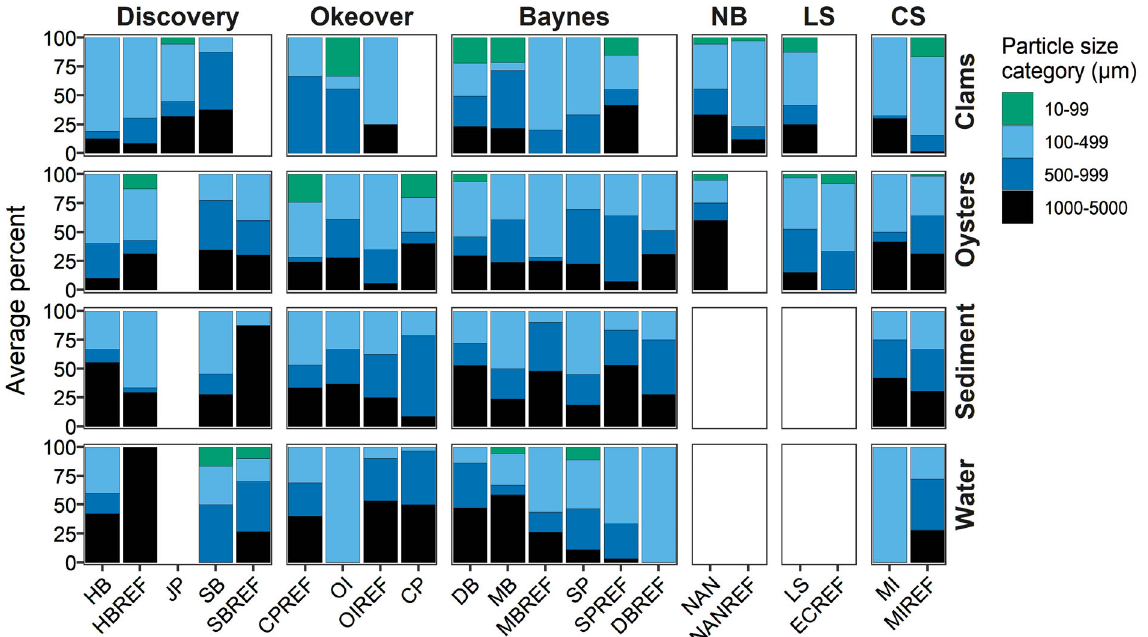
Fig. 3. Average proportion of various potential microplastic particle sizes (longest dimension) of samples that contained these particles in Manila clams Venerupis philippinarum , Pacific oysters Crassostrea gigas , sediment samples, and seawater sam- ples. Study region is indicated at the top. See Fig. 1 for site and region abbreviations. White spaces indicate where samples from a certain site/type were not